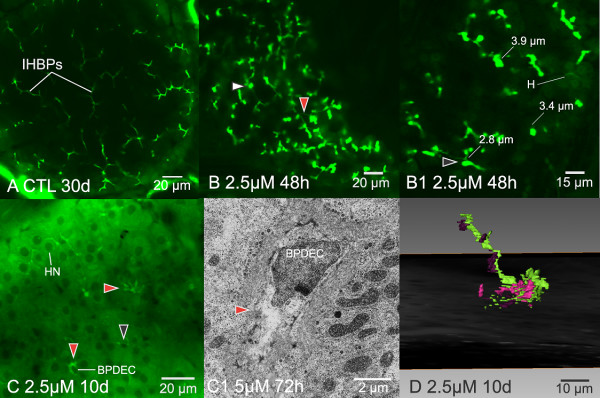
In vivo imaging of hepatobiliary toxicity: canalicular attenuation/dilation and bile preductular lesions. (A) In vivo confocal image of untreated medaka liver (30 dpf), illustrating normal appearance of IHBPs, characterized by uniform diameter. (B – B1) In vivo confocal image, single optical section, of ANIT treated medaka liver (24 dpf) illustrating appearance of dilated and attenuated bile canaliculi (red arrowhead points to attenuation, white to dilation), 48 hrs post exposure to 2.5 μM ANIT. Canaliculi were elucidated with fluorescein isothiocyanate. Only the intrahepatic biliary passageways are fluorescent (green). Parenchyma is largely non fluorescent, aside from weak and diffuse fluorescence of hepatocellular cytosol. Canalicular dilation/attenuation appeared to be a canalicular constriction/dilation regulatory problem, as no clear alteration to hepatocyte morphology was observed in association with this change. (B1) Dilated canaliculi (gray arrowhead) were found to be up to approximately 3 times normal diameter (e.g., 3.9 μm diameter in dilated vs. 1.3 μm average diameter in normal canaliculi). Attenuated canaliculi were distinct, appearing as fine sinuous passageways measuring 0.4 μm to 0.8 μm in diameter. (C) Non invasive in vivo confocal image 10 days post exposure to 2.5 μM ANIT (chronic exposure) showing bile preductular lesions (red arrowhead), characterized by loss of preductule membrane integrity and loss of uniformity in preductule lumen diameter. Intrahepatic biliary passageways elucidated here with Bodipy C5 Ceramide. Black arrowhead illustrates normal appearance of bile preductule. (C1) Transmission electron micrograph illustrating changes to bile preductular epithelium (BPDEC) associated with preductular lesions, which showed increased cytosolic area and vacuolation (red arrowhead). In vivo observations helped lead to the hypothesis that ANIT induced BPDEC toxicity is responsible for bile preductular lesions observed, and that these cells are early targets of ANIT. (D) Example of a 3D reconstruction of damaged preductule that revealed the damaged bile passageway (green) was blind ending, not interconnected with other segments of the intrahepatic biliary network (atypical). Also shown are bile preductular epithelial cells (purple), illustrating the foci of alteration was a canaliculo-preductular junction. In (A), (B), and (B1), IHBPs elucidated with FITC, in (C) with Bodipy C5 ceramide.